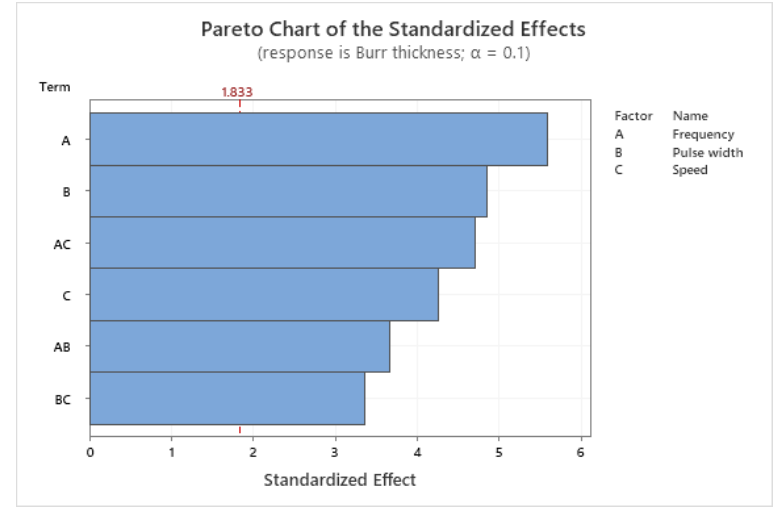
Figure 7. Pareto Chart of the Standardized Effects for Burr thickness.